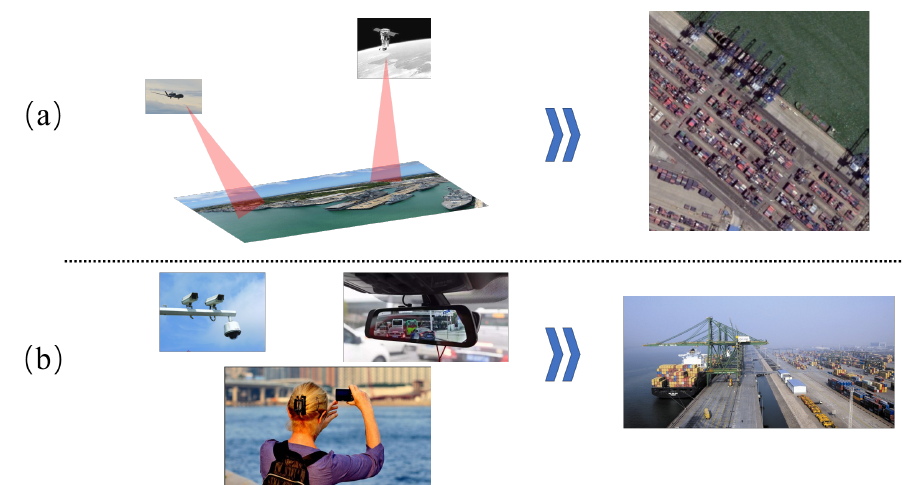
Figure 1. The difference between natural images and aerial images. ( a ) A port image data obtained by aerospace platforms or aviation platforms. ( b ) A port image data captured by surveillance equipment or handheld